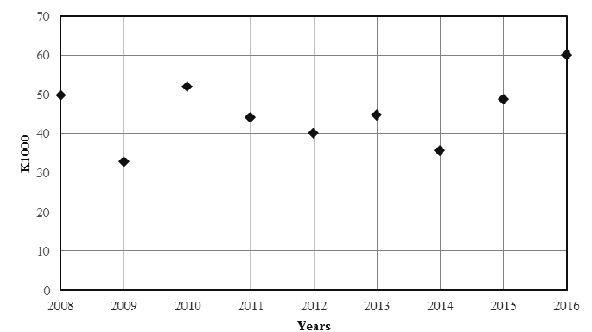
Fig. 2. Changes of the coefficient K1000 for SCF-PP aviation occurrence categories